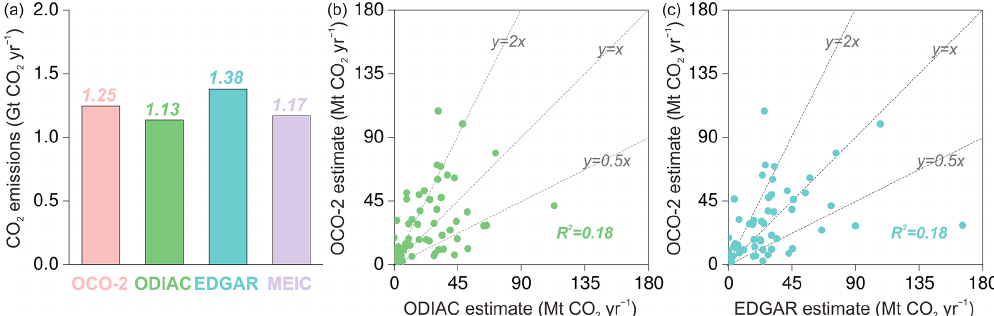
Figure 4. Comparing OCO-2-based CO 2 emission estimates with bottom-up inventories. (a) The sum of emissions from the different regions observed by OCO-2 between the years 2014 and 2018, including OCO-2 estimates (scaled up to annual emissions based on MEIC emission time profiles, pink bar), ODIAC (green bar), EDGAR (blue bar), and MEIC (purple bar) estimates. (b) Comparison of regional CO 2 emissions between OCO-2-based ( y axis) and ODIAC estimates ( x axis). (c) Comparison of regional CO 2 emissions between OCO-2-based ( y axis) and EDGAR estimates ( x